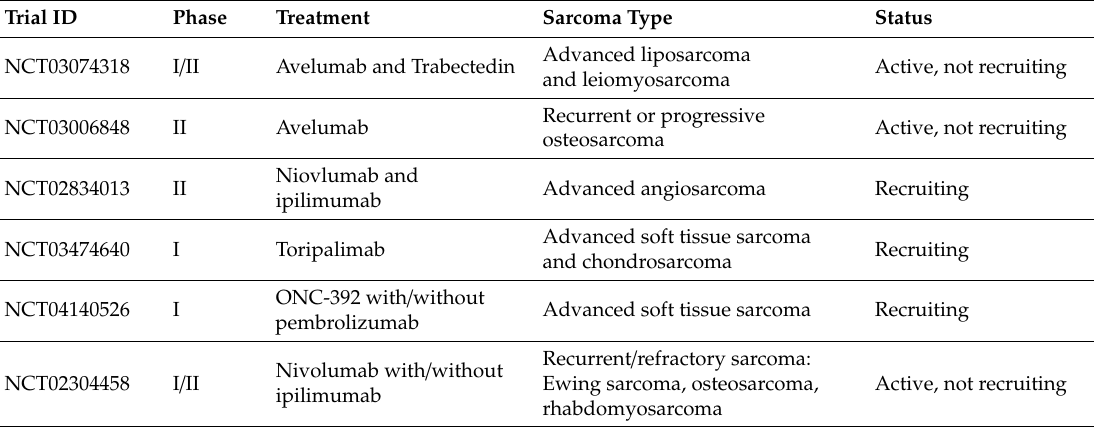
Table 1. List of ongoing clinical trials for sarcoma